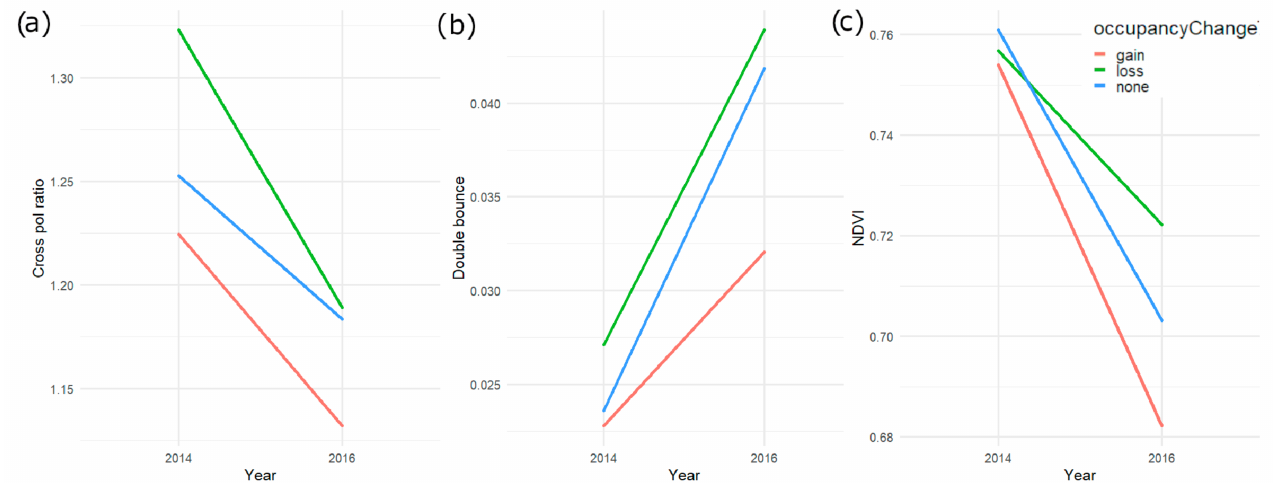
Figure 5. Yearly trends in three EO indies between 2014 and 2016 for three sites types. ( a ) cross polarization ratio ( b ) double bounce, and ( c ) NDVI.